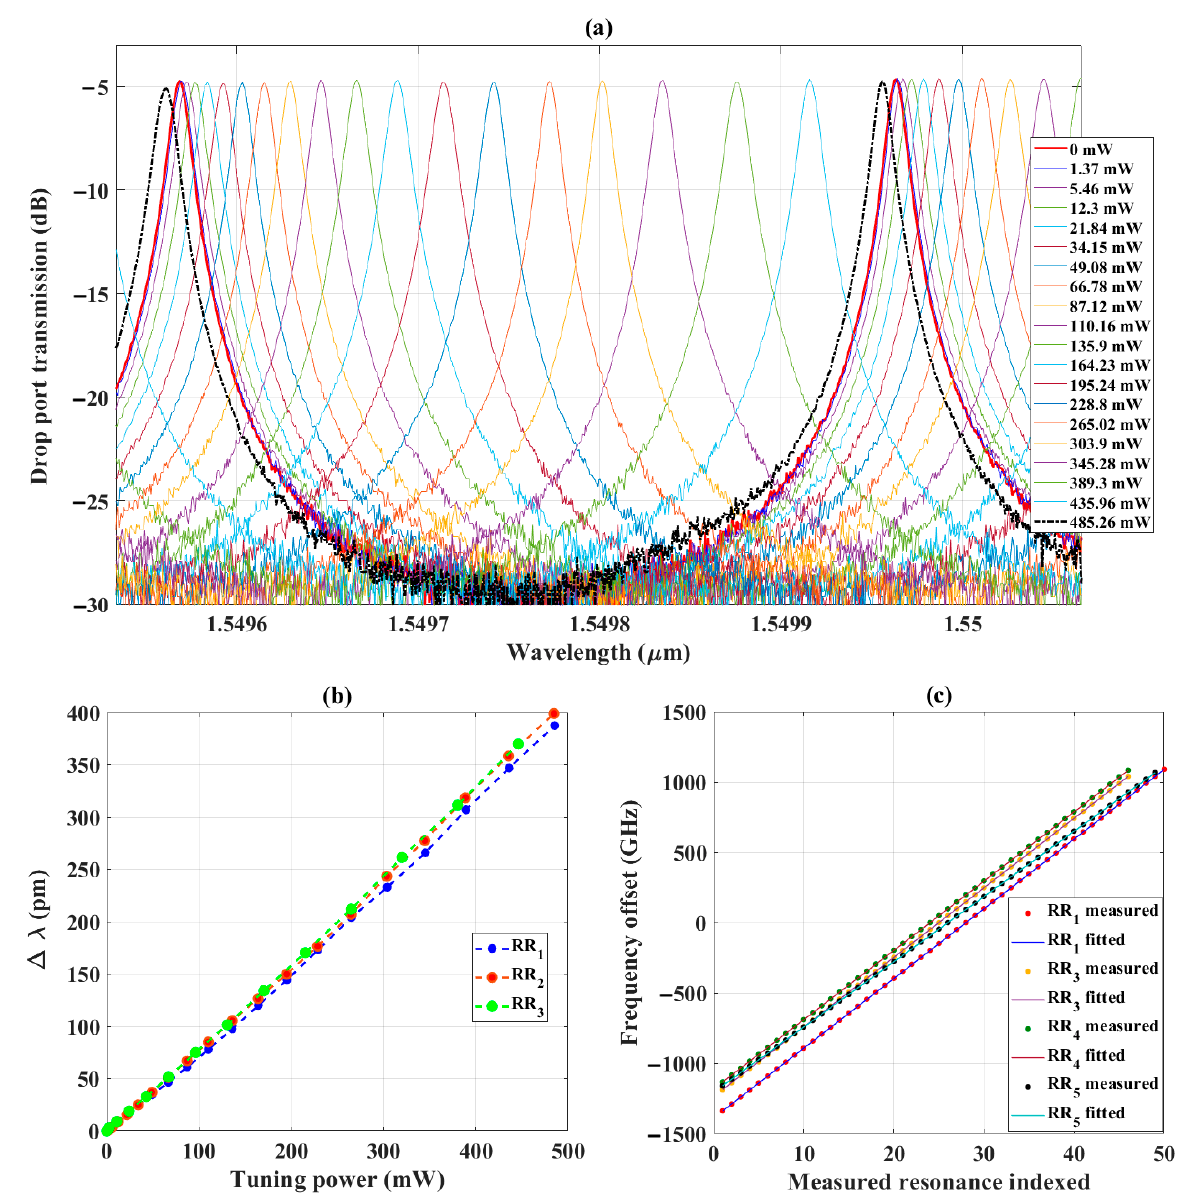
Figure 4. ( a ) Tuning spectra of RR 1 for different thermo-optic phase shifter applied voltage, ( b ) resonant wavelength shifts of RR 1 , RR 2 , and RR 4 as a function of heater power, and ( c ) linear fit to the multiplicity of resonant frequencies for RR 1 , RR 3 , RR 4 , and RR 5 .